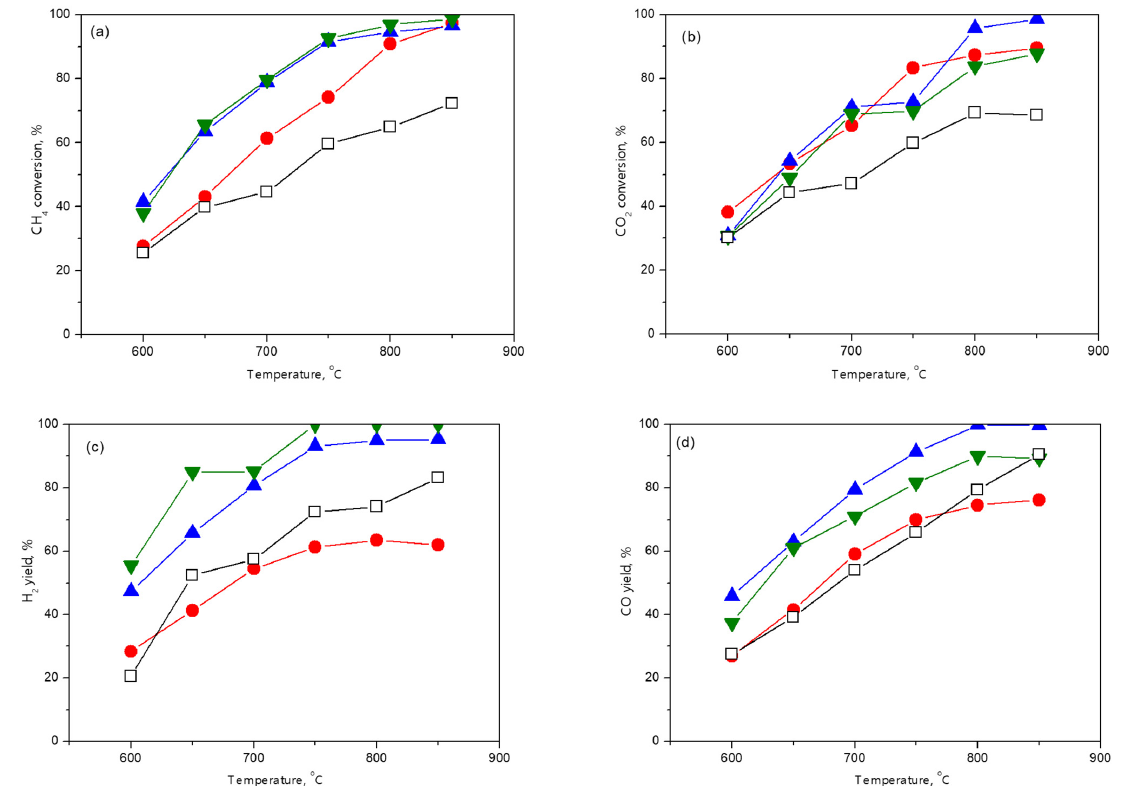
Figure 19. Temperature dependence of CH 4 conversion ( a ), CO 2 conversion ( b ), H 2 yield ( c ), and CO yield ( d ) during the bi-reforming of methane over (CeM) 0.8 Ni 0.2 O y samples: effect of M type. M/Ce molar ratio is equal to 1.